Question: What type of chart is this?
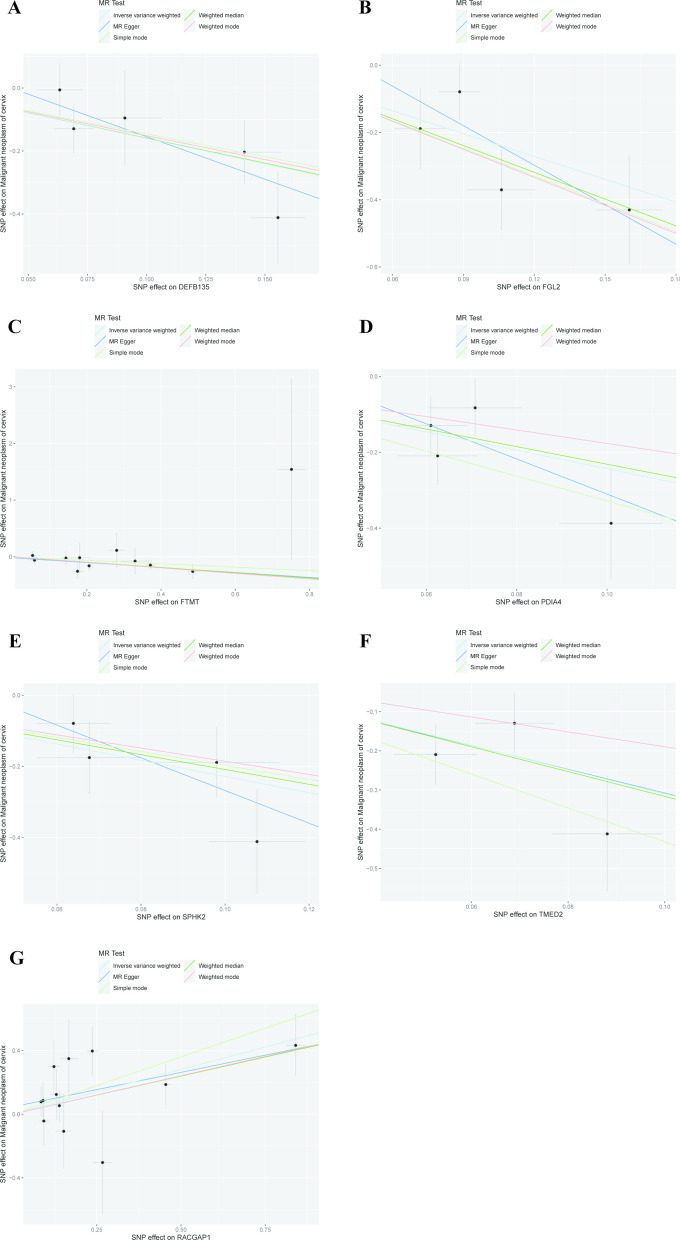
Answer: scatter